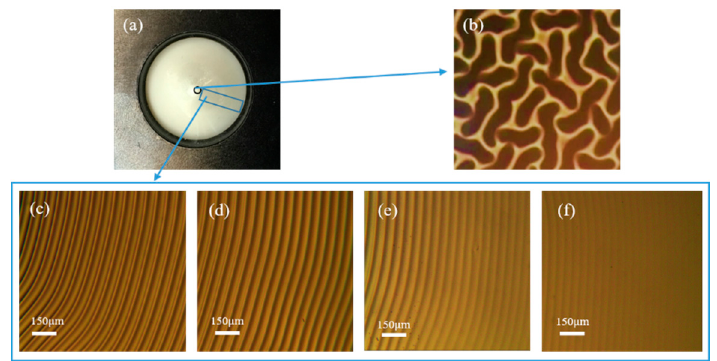
Figure 6. After releasing the pre-strain, the resulting ring wrinkles were observed by an optical microscope. ( a ) The whole membrane in ambient light. ( b ) Optical image of the center of the membrane. ( c – f ) Concentric ring wrinkles with continuously changing wavelength from the center of the membrane to the edge in the blue rectangle of Figure 6a corresponding to the gradual increase of d .